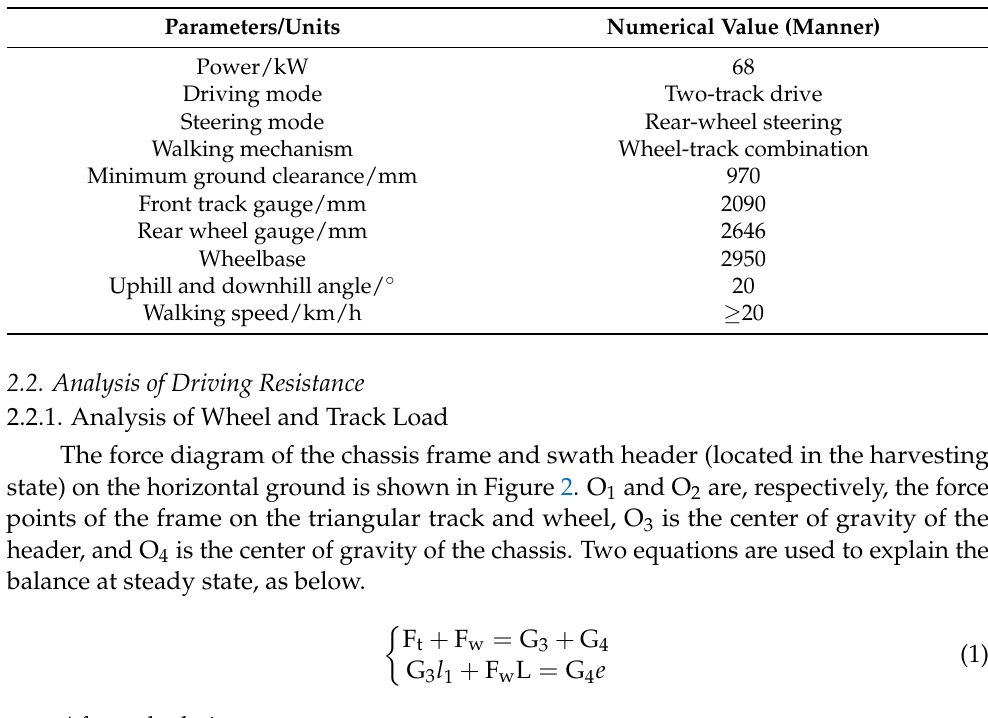
Table 1. Main technical parameters of the wheel-track high clearance